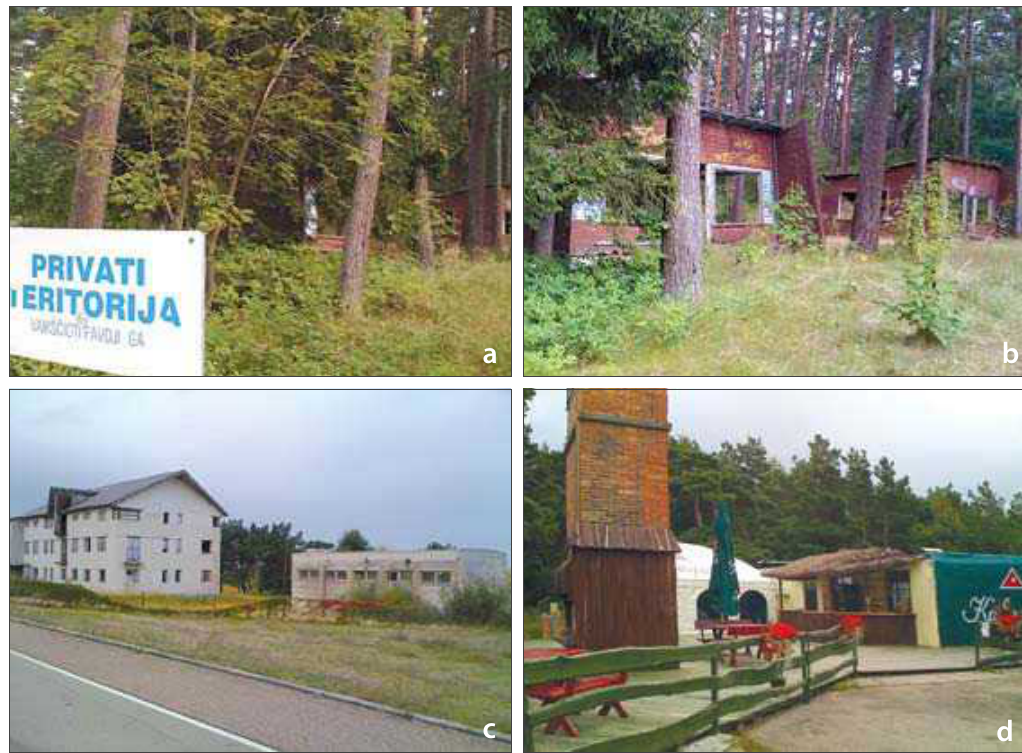
Fig. 22. ecological and visual polution in Neringa (a, b, c,